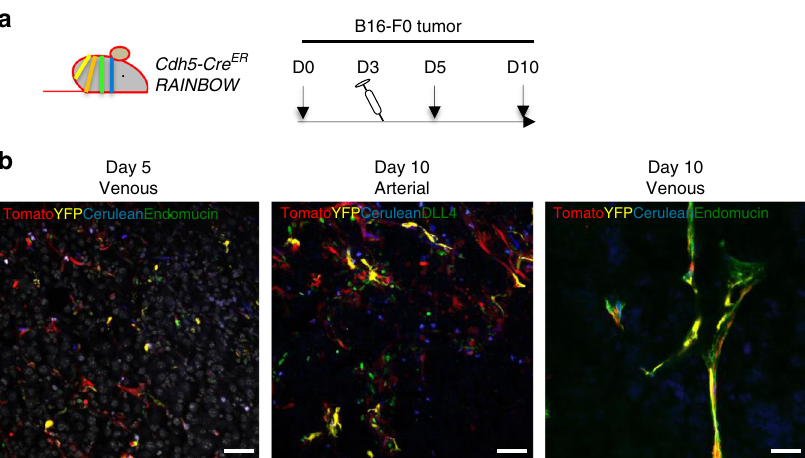
Fig. 5 Clonality of the tumor vasculature. a Schematic diagram of the Cdh5-Cre ER Rainbow lineage tracing model employed with B16-F0 melanoma cells injected at day 0 (D0), with mice receiving tamoxifen (Tam) 3-days post tumor inoculation ( n = 5). b At day 5 multi-individual colored clones could be observed that were presumed to be EVP. By day 10 entire arterial (DLL4) and venous (endomucin-higher magni fi cation) vessels were composed of multi colors demonstrating polyclonality. Scale bar represents 50 – 150 μ m. EVP endovascular